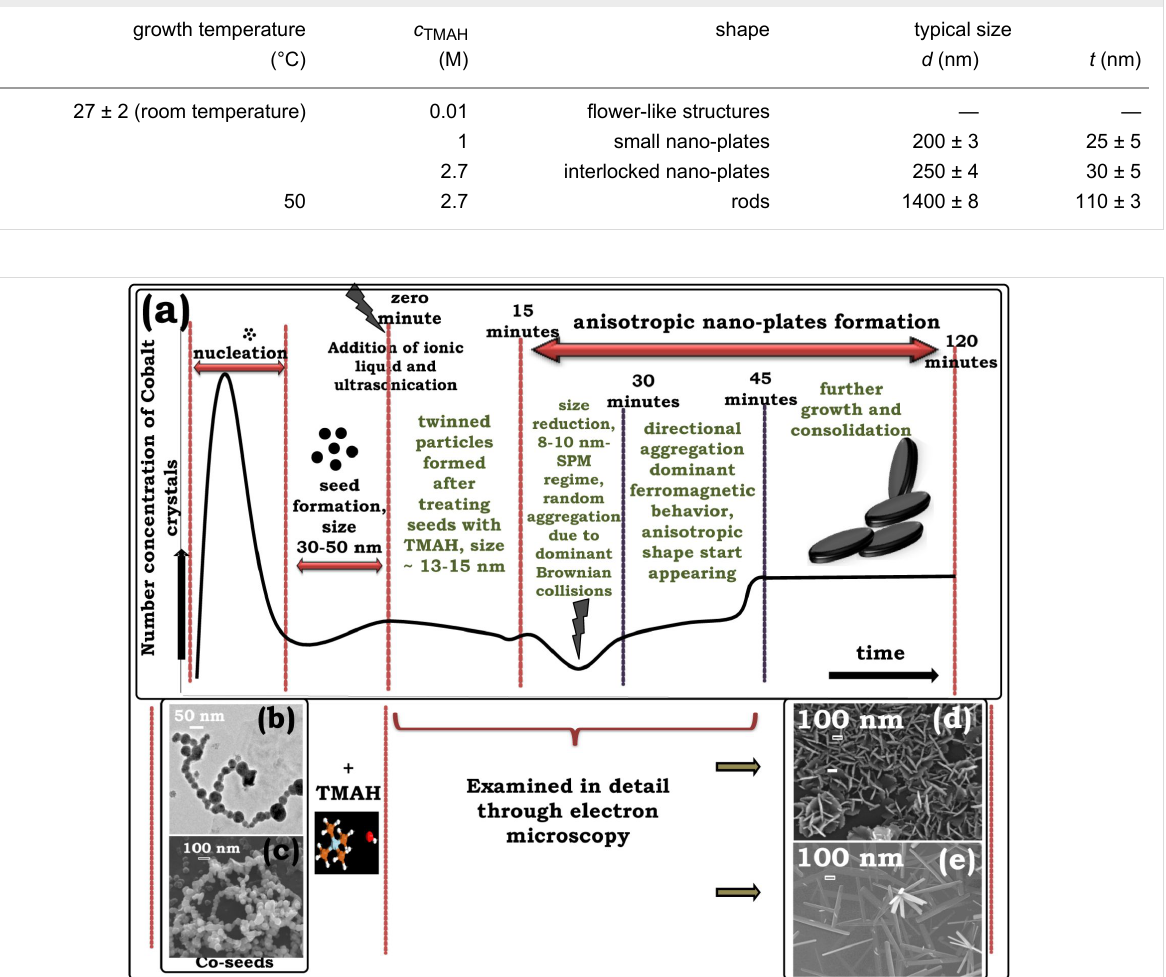
Table 1: Effect of various parameters on cobalt-nanoplates formed in the presence of TMAH: All values are reported after 45 min; the concentration of cobalt precursor and reducing agent were 0.4 M and 0.01 M, respectively. Viscosity of TMAH = 2.8 cSt at 25 °C, ionic radii: TMA + = 2.9 Å, and OH − = 0.95 Å.